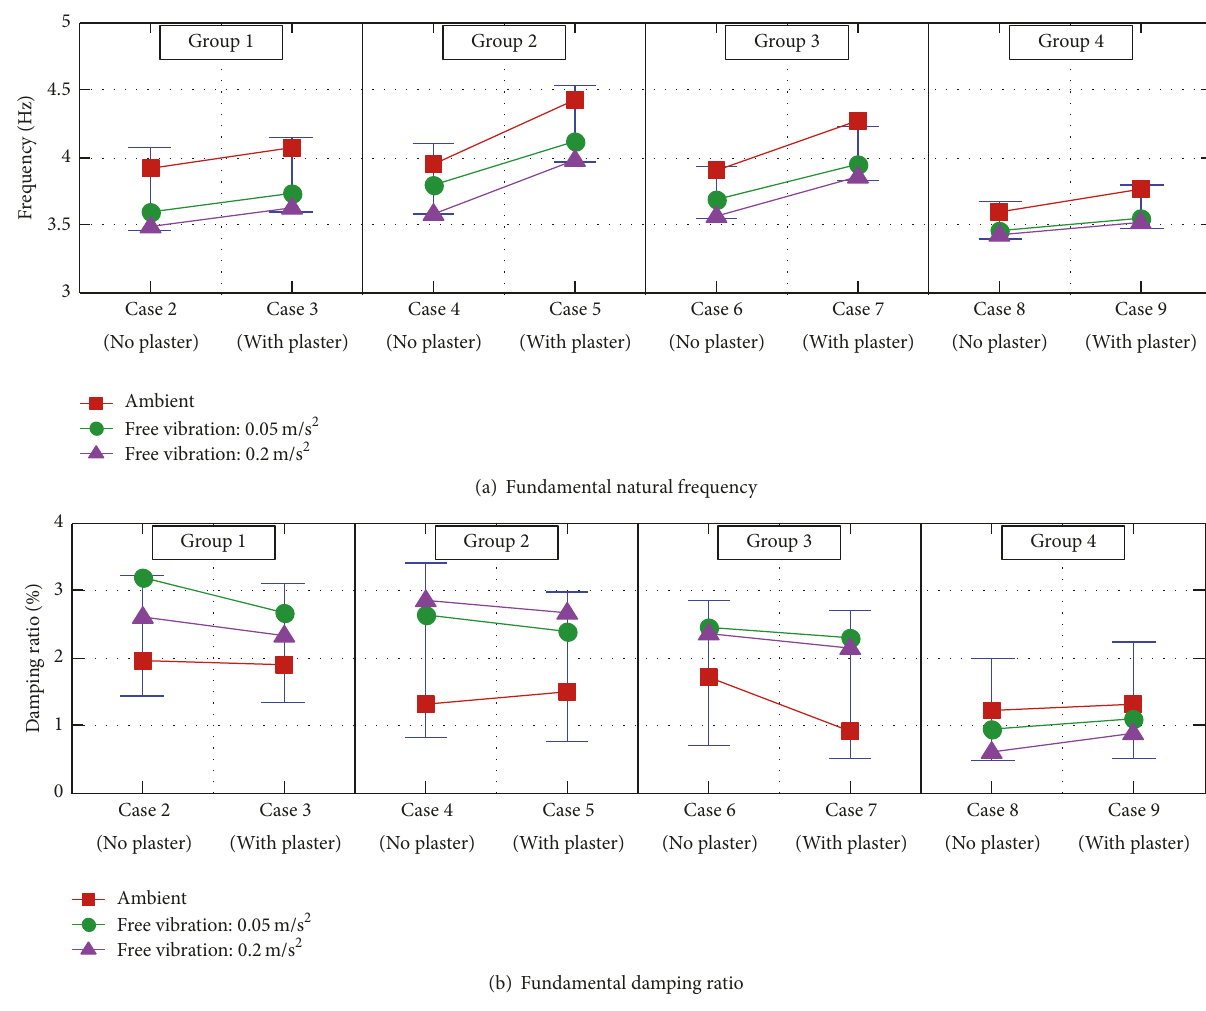
Figure 14: Effect of plasterboard on dynamic characteristics of steel